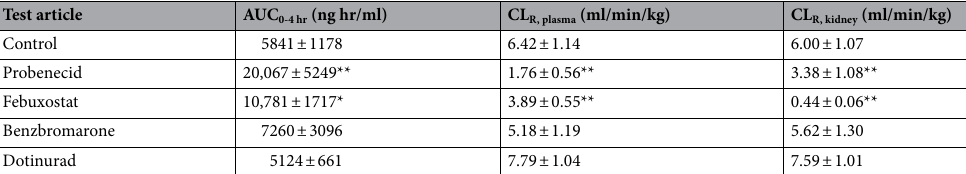
Table 2. Pharmacokinetic parameters of endogenous IS in intact rats. AUC 0-4 hr : area under the curve from 0 to 4 h, CL R, plasma : plasma concentration-based renal clearance, CL R, kidney : kidney concentration-based renal clearance. Data were analyzed using the Phoenix WinNonlin 6.4 software (Certara, L.P., Princeton, NJ) or calculated using the following equations: CL R, plasma = (urine IS concentration × urine volume) / AUC 0-4 hr , CL R, kidney = (urine IS concentration × urine volume) / (kidney IS concentration at 4 h × 4). Each value is presented as mean ± SD of four to six animals. *, ** P < 0.05, P < 0.01, significantly different from the control group according to Dunnett’s multiple comparison